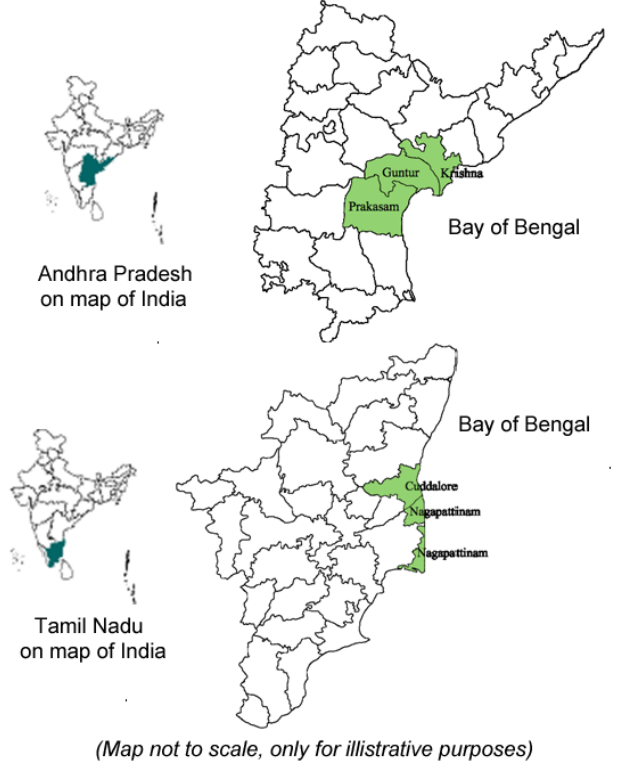
Fig. 1 . Location of the study area on the map of Andhra Pradesh and Tamil Nadu,